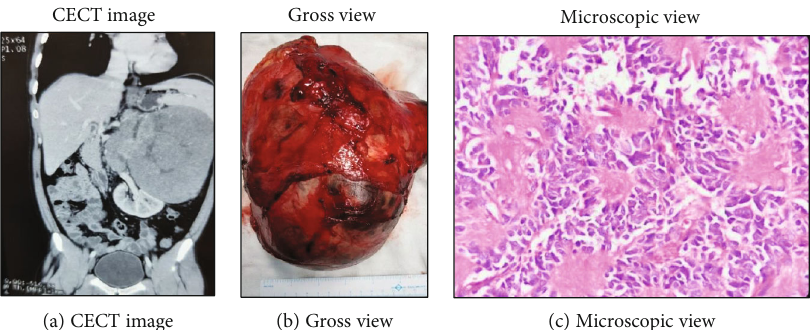
Figure 1: Left adrenal